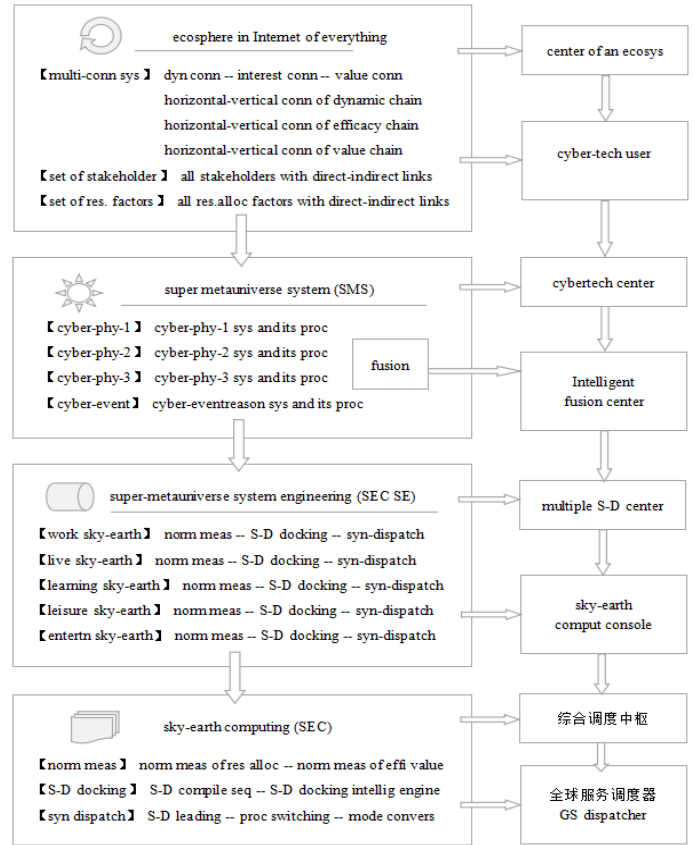
Fig. 2. Super metauniverse system which comes down to super-metauniverse system